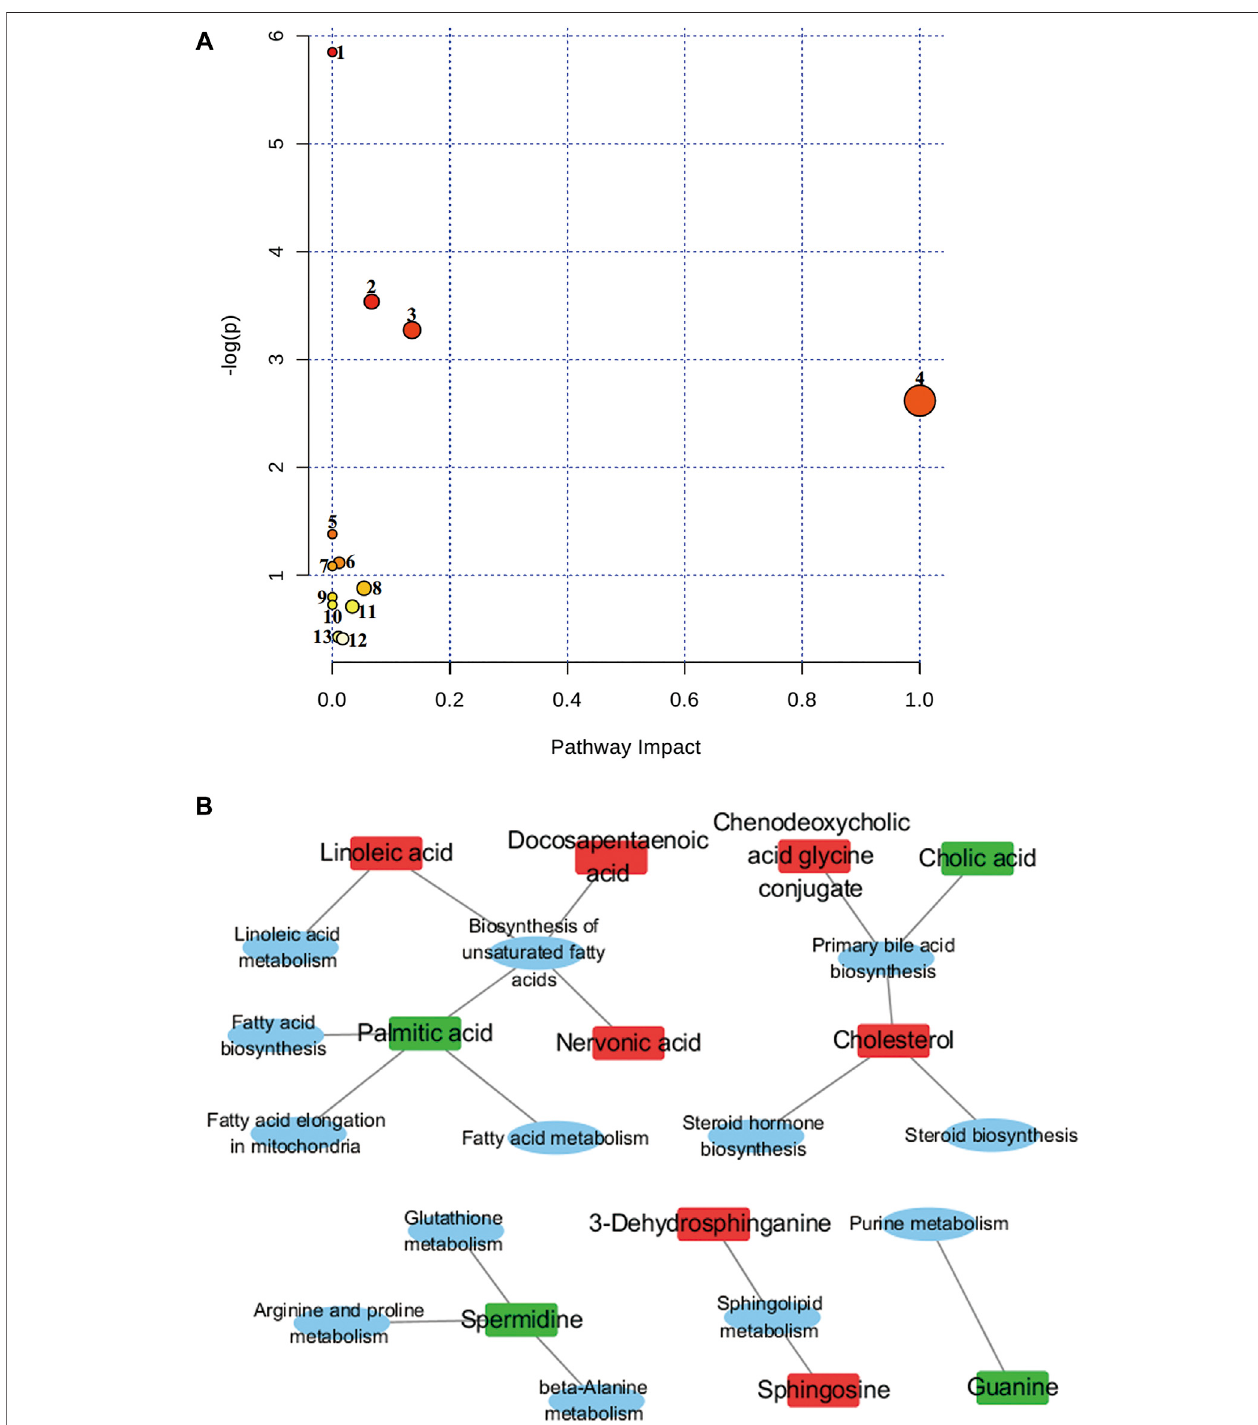
FIGURE 5 | Topological mapping of potential biomarkers based on METPA analysis (A) . (1) Biosynthesis of unsaturated fatty acids, (2) primary bile acid biosynthesis, (3) sphingolipid metabolism, (4) linoleic acid metabolism, (5) beta-alanine metabolism, (6) glutathione metabolism, (7) fatty acid elongation in mitochondria, (8) steroid biosynthesis, (9) fatty acid metabolism (10) fatty acid biosynthesis (11) arginine and proline metabolism (12) purine metabolism and (13) steroid hormone biosynthesis. Relationship between metabolic pathways and related metabolites of R. Scrophulariae involved in the treatment of hyperthyroidism rats (B) . The elliptical nodes represent pathways, and the rectangular nodes represent metabolites (red: upregulation, green: downregulation).